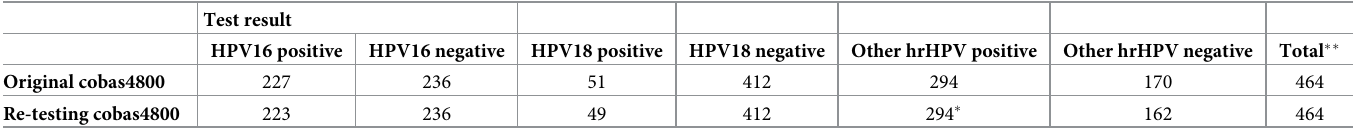
Table 1. Distribution of HPV positive and negative results in the original cobas4800 test, and the re-test cobas4800 result, respectively.